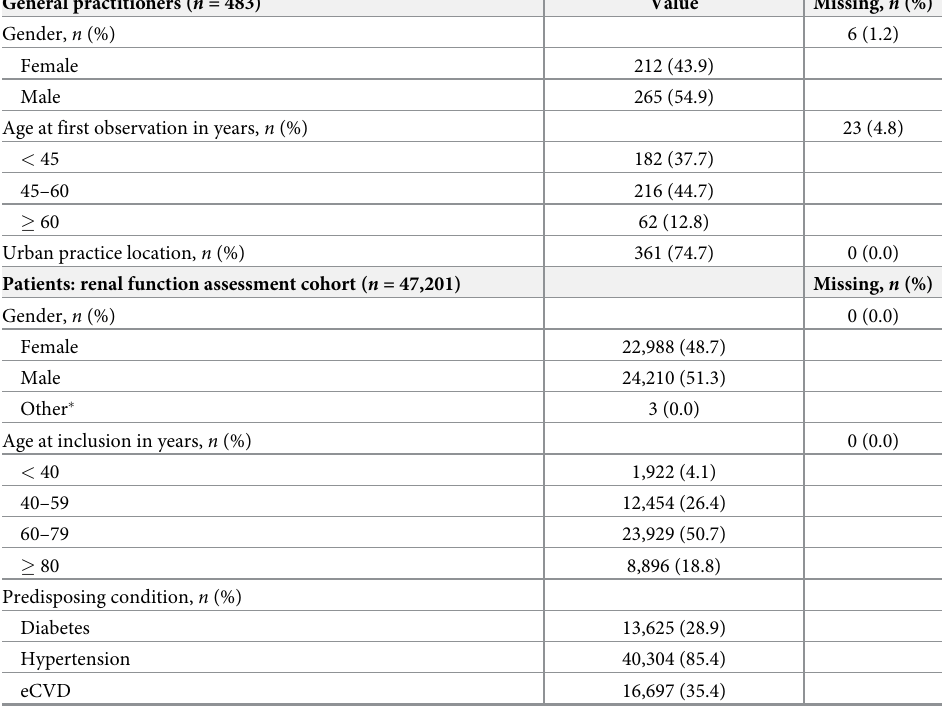
Table 2. Study participant